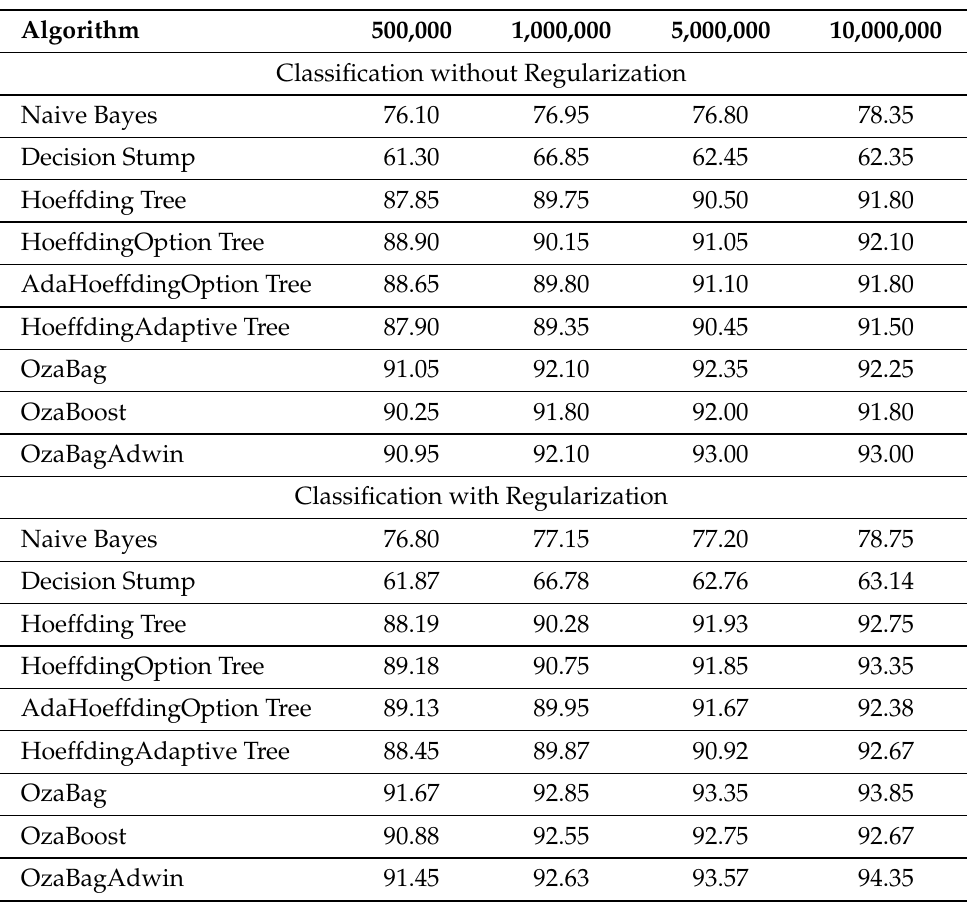
Table 7. Accuracy percentages of weather classification for different dataset sizes for training set =